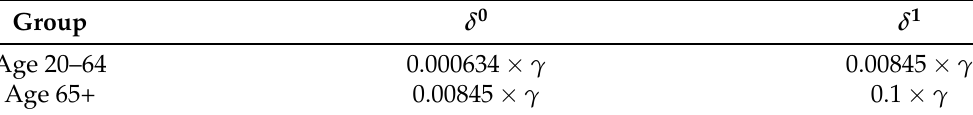
Figure 6. Comparison of optimal lockdown policy to no lockdown, using benchmark parameters. Optimal lockdown deaths: 0.3266% vs. uncontrolled deaths: 0.6189%. Table 1. Death rates estimated using [16]. γ = 1/18 is the recovery rate as listed in Table A1.